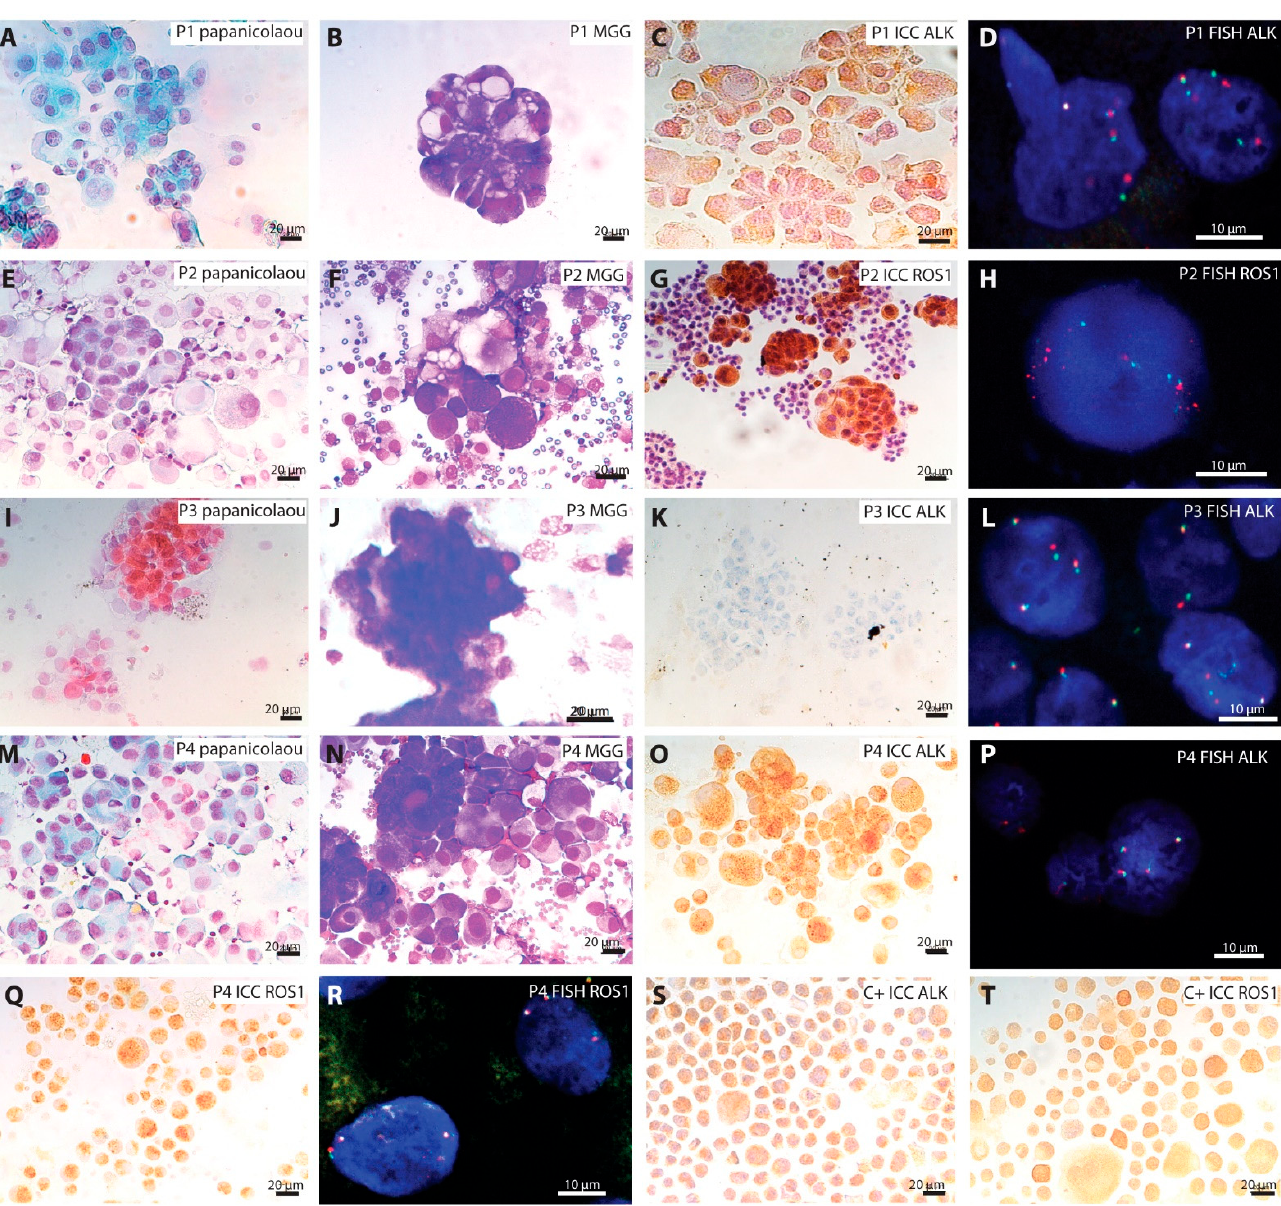
Figure 1. Example of malignant cells with or without ALK and ROS1 rearrangements . ( A – D ) Represent the cytology of pleural effusion (P1) containing ALK rearranged malignant cells. ( A ) Papanicolaou stain, ( B ) May–Grünwald–Giemsa (MGG) stain, ( C ) immunocytochemistry (ICC) (peroxidase staining) using antibody against ALK (clone 5A4), ( D ) ALK FISH probe. ( E – H ) Represent the cytology of pleural effusion (P2) containing ROS1 rearranged malignant cells. ( E ) Papanicolaou stain, ( F ) May–Grünwald–Giemsa stain, ( G ) immunocytochemistry (peroxidase staining) using antibody against ROS1 (clone D4D6), ( D ) ROS1 FISH probe. ( I – L ) Represent the cytology of a lymph node (P3) containing ALK rearranged malignant cells. ( I ) Papanicolaou stain, ( J ) May–Grünwald–Giemsa stain, ( K ) immunocytochemistry (peroxidase staining) using antibody against ALK (clone 5A4), ( L ) ALK FISH probe. Of note, the false-negative result was obtained with ICC, whereas the rearrangement is observed with FISH. ( M – R ) Represent the cytology of pleural effusion (P4) containing malignant cells without ALK and ROS1 rearrangements. ( M ) Papanicolaou stain, ( N ) May–Grünwald–Giemsa stain, ( O ) immunocytochemistry (peroxidase staining) using antibody against ALK (clone 5A4), ( P ) ALK FISH probe. ( Q ) Immunocytochemistry using antibody against ROS1 (clone D4D6), ( R ) ROS1 FISH probe. Of note, the false-positive results were obtained with ICC using antibodies against ALK and ROS1, whereas the FISH shows more than two signals without rearrangement using ALK and ROS1 probes. ( S ) H2228 cell line showing positive staining against anti-ALK antibody (positive control, C+). ( T ) HCC78 cell line showing a positive staining against anti-